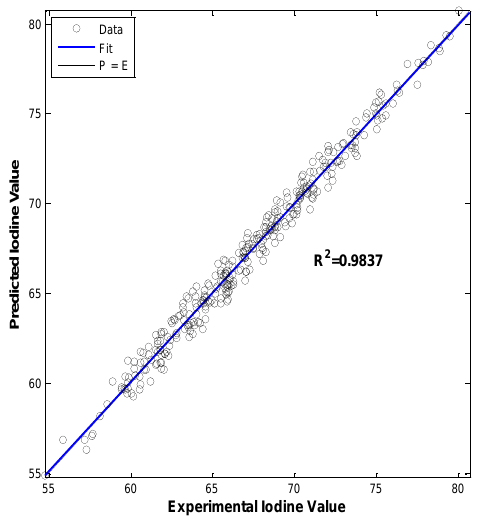
Fig. 4 Predicted Iodine value vs. experimental iodine value for the test set (332